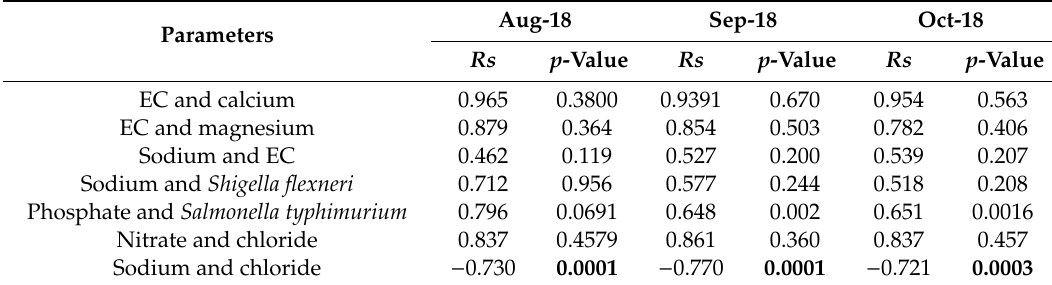
Table 4. Results of correlation